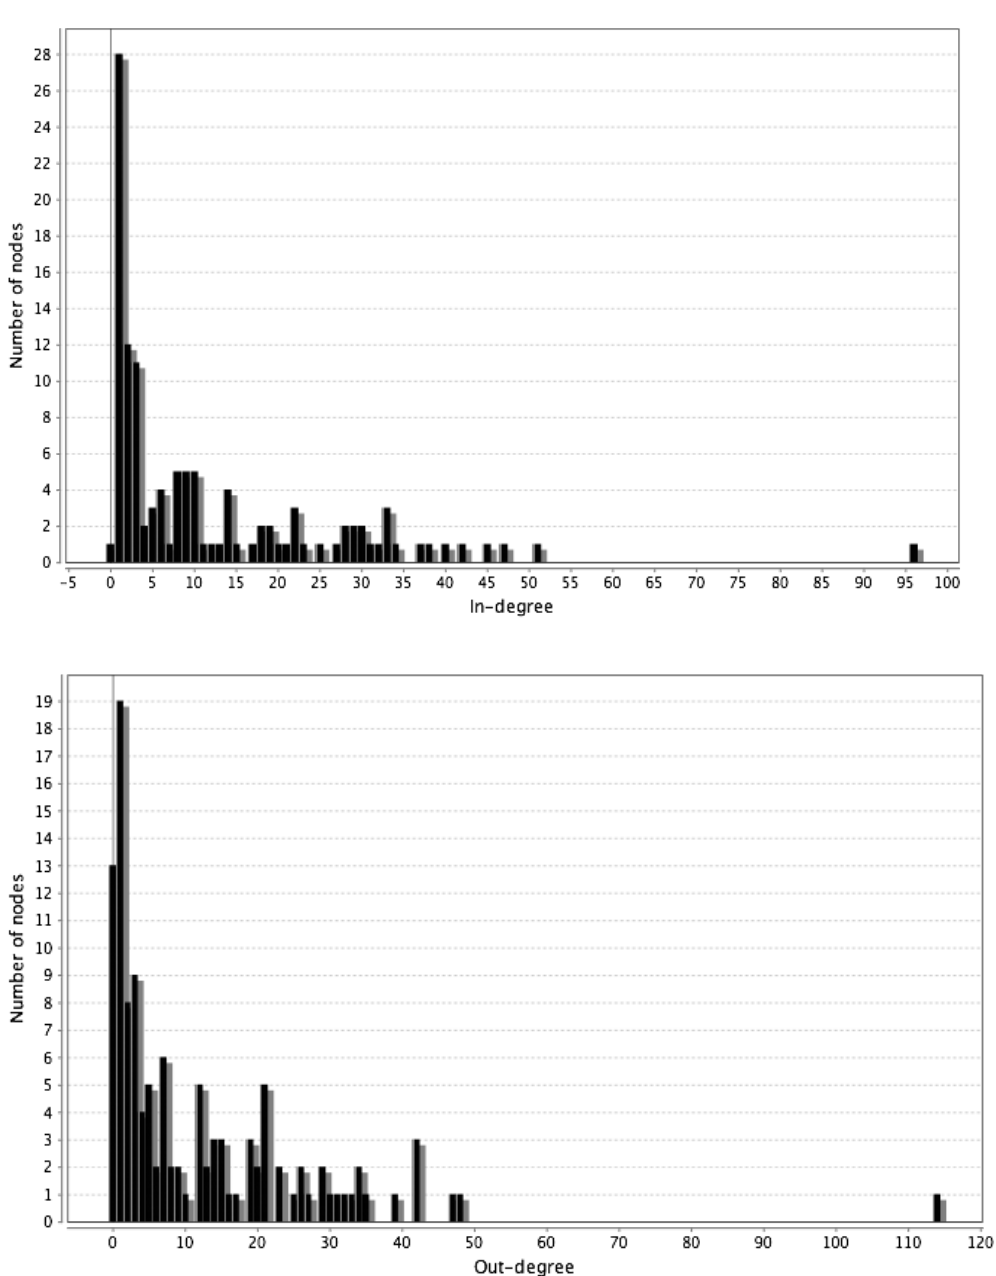
Figure 7 . In-degree (A) and out-degree (B) distribution of the members in the Books relations network. On the other side, small communities with highly-linked members can be a great source of information, as is the case of Apps , whose members have an average number of 32 potential connections out of 40 members. In this case, the community represents a tight crowd as all the members are highly connected between them (see Figure 8). In Figure 8 the two central nodes are highlighted in red and the less connected node in